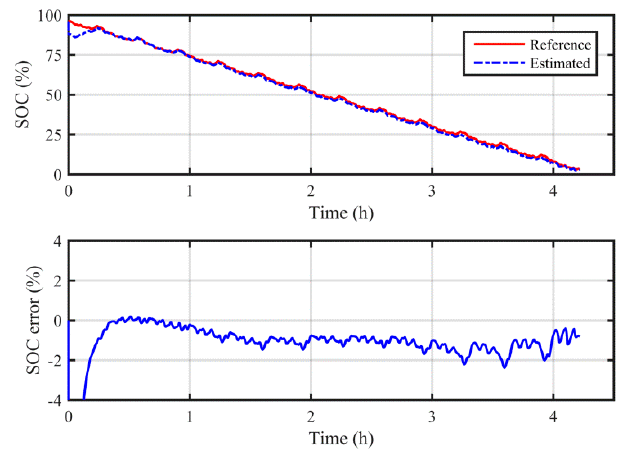
Figure 5. Results of SOC estimation with the proposed method. Table 2. Performance of the proposed method on voltage prediction and SOC estimation for the hybrid pulse experiment.